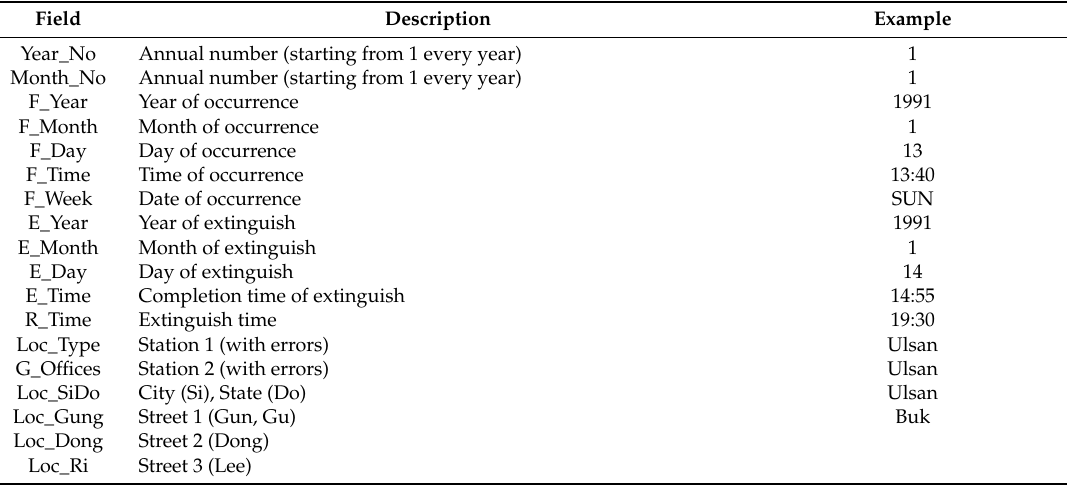
Table 1. Fire damage data from the forest fire prediction model.